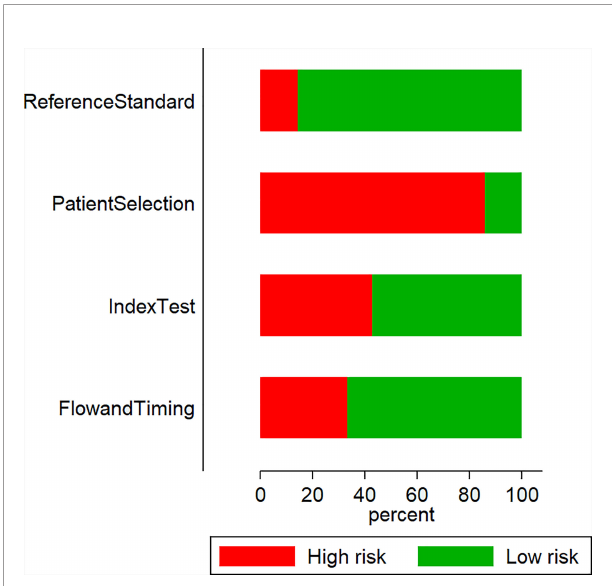
FIGURE 2 | Quality assessment among the included studies using QUADAS- 2 tool (n =